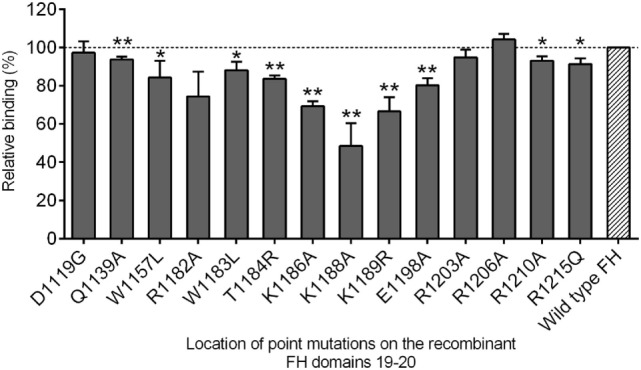
Factor H (FH) autoantibody binding to single amino acid-substituted recombinant FH short consensus repeat (SCR) domains 19–20 compared to the wild type protein. The amino acid substitutions are indicated on the x axis with capital letters, and numbers marking their location (gray bars) compared to the recombinant wild type FH SCRs 19–20 (striped bar). Binding is expressed in percent relative to that of the wild type (100%, intermittent line). We tested the sera of three patients in the acute phase of atypical hemolytic uremic syndrome; mean and SEM of three independent experiments are shown. Statistical analysis was performed with the one-sample Wilcoxon signed-rank test; statistical significance is indicated by asterisks (*p < 0.05; **p < 0.01).